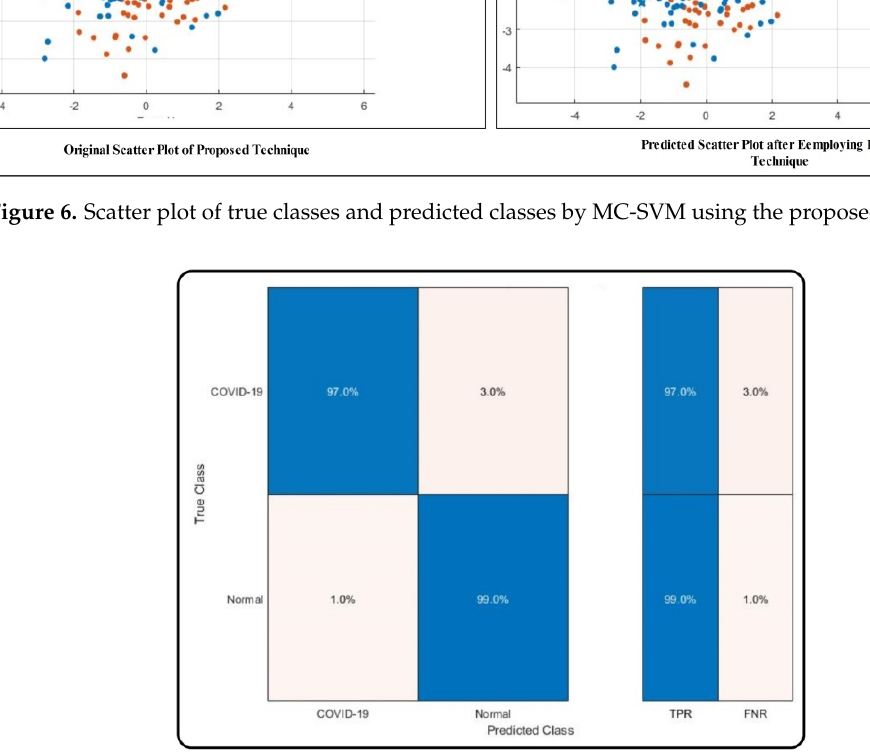
Figure 7. Confusion matrix of the MC-SVM classifier using the proposed technique.